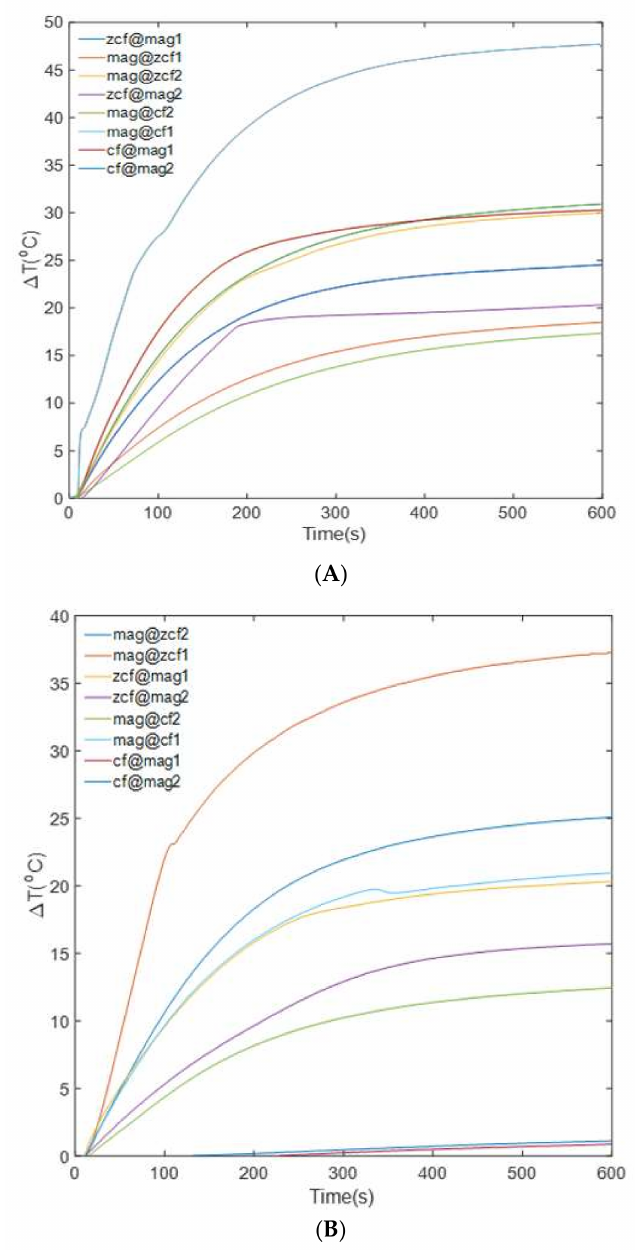
Figure 4. Temperature increases for various core-shell MFNs under magnetic field strengths of ( A ) 50 and ( B ) 40 kA /